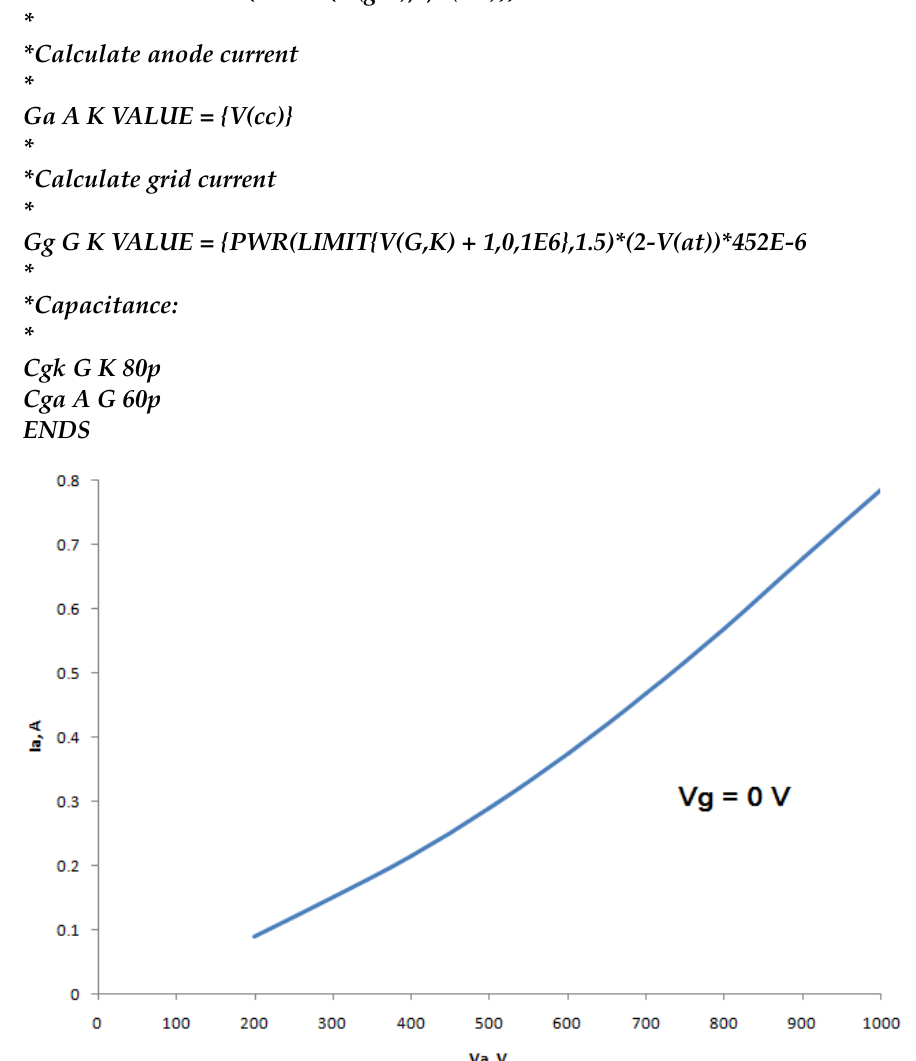
Figure 2. Chart of anodic current dependence on anode voltage at constant grid voltage.